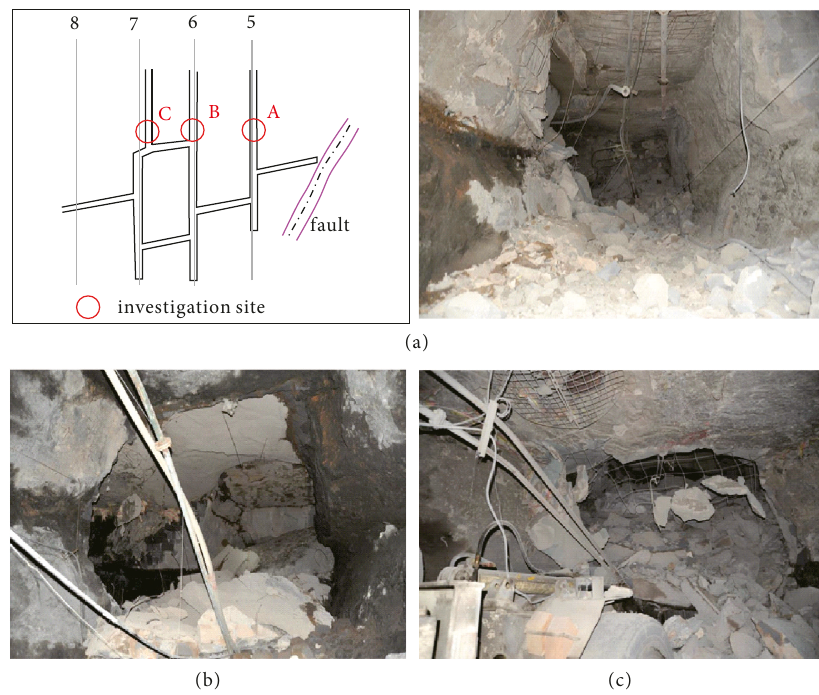
Figure 5: The location of the investigation and the filed destructions at the 1613 m level.